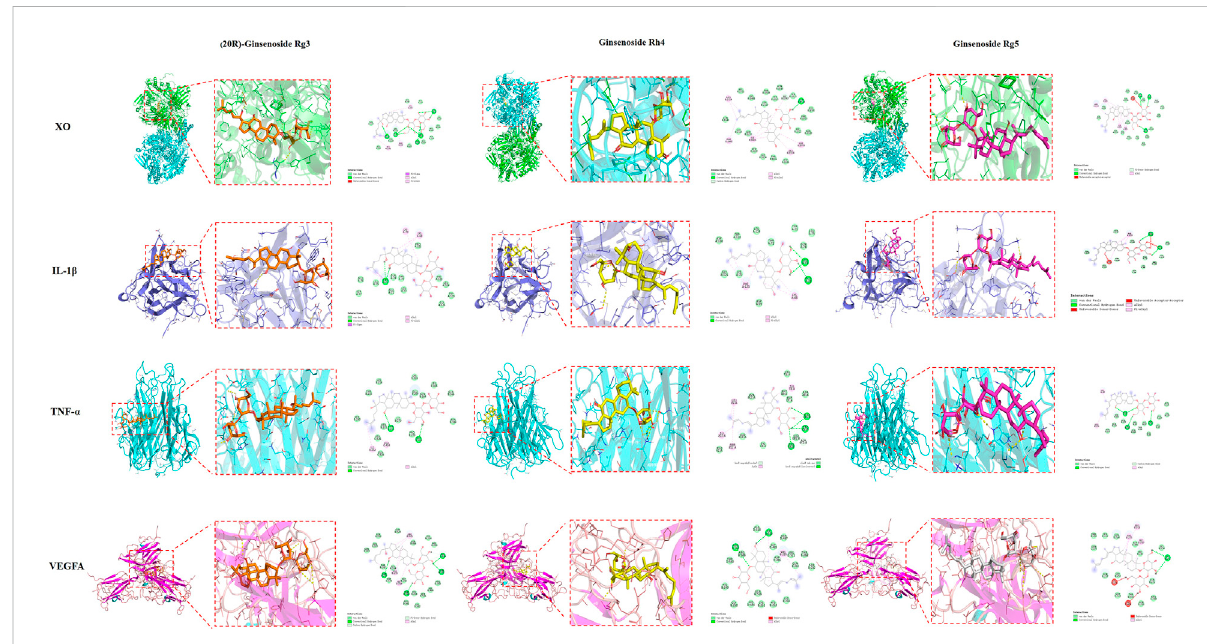
FIGURE 6 Molecular docking of 20(R)-ginsenoside Rg3, ginsenoside Rg5, and ginsenoside Rh4 with TNF- α , IL-1 β VEGFA, and XO,